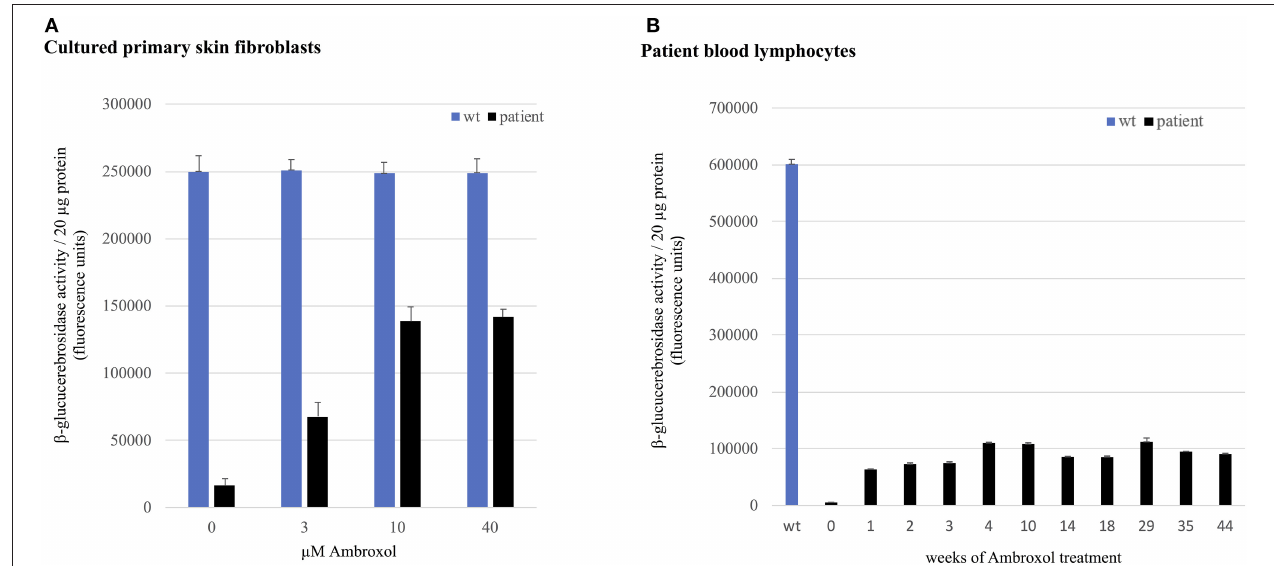
FIGURE 3 | GCase activity in skin fibroblasts and lymphocytes. GCase activity in (A) patient’s primary skin fibroblasts compared to healthy donor cells (wild-type, wt) and (B) in patient lymphocytes compared to healthy donor cells (wt) at weeks 0–44 of ambroxol treatment.